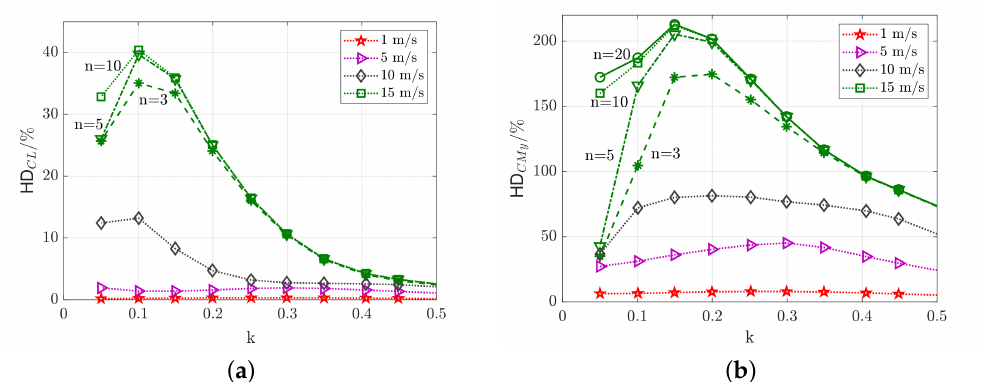
Figure 18. Harmonic distortion for Mach 0.70, ( a ) HD CL (Note: lines for n = 50 and n = 20 coincide with n = 10 and are not displayed), ( b ) HD CMy (Note: the line for n = 50 coincides with n = 20 and is not